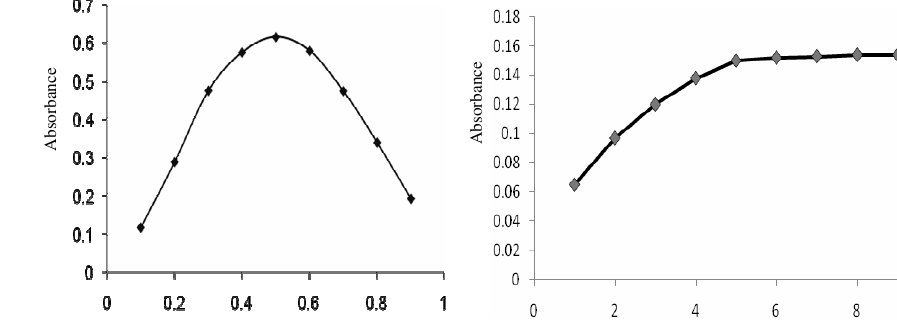
Figure 5. Mole-ratio method plot of pioglitazone-BCG ion-pair